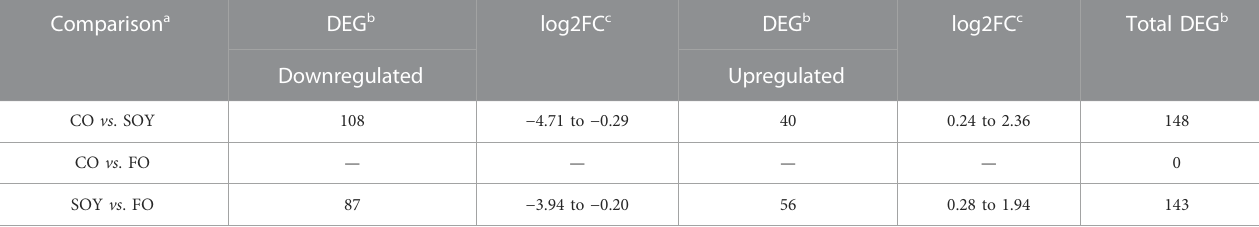
TABLE 2 Differentially expressed genes found in the liver tissue of pigs fed with different oils in the diet. Comparison